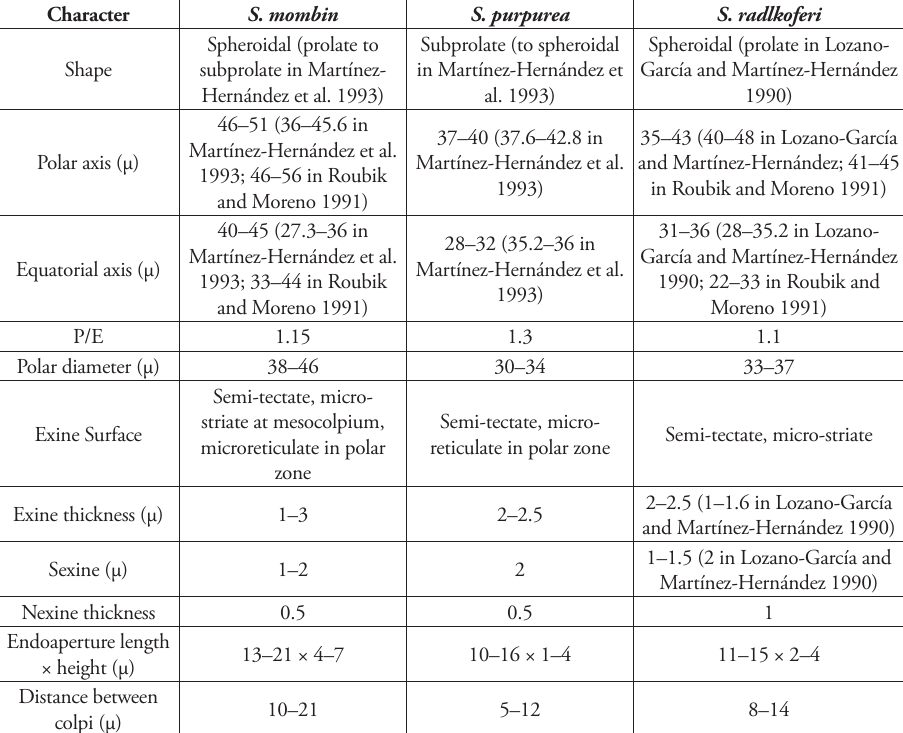
Table 2. Comparison of pollen morphology of three species of Spondias ; data from Olivera et al. (1998) except where